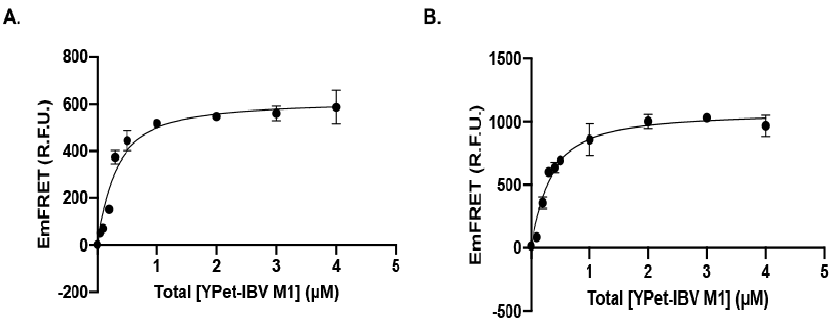
Figure 4. The SUMOylation E2 conjugation enzyme, Ubc9, and E3 ligase, PIAS1, interact with M1 protein of IBV at a very high affinity determined with a qFRET assay ( A ). The interaction affinity K D value of 0.2 µ M between Ubc9 and M1 was determined using the qFRET assay in solution ( B ). The interaction affinity K D value of 0.22 µ M between PIAS1 and M1 was determined using the qFRET